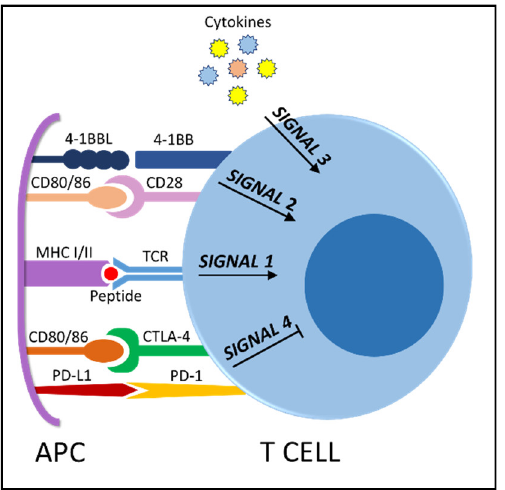
Figure 2. T cell activation requires 3 signals: T cell receptor (TCR) stimulation, co-stimulatory mol-